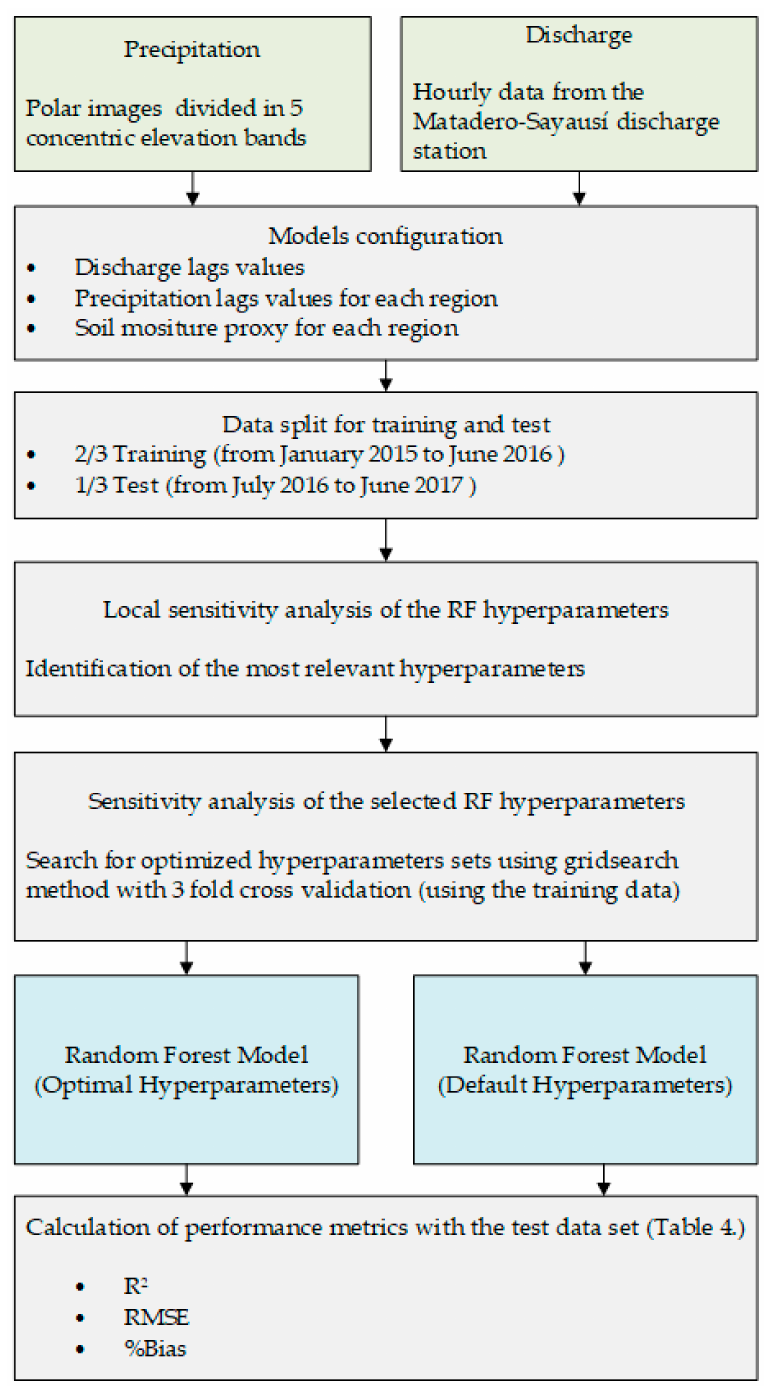
Figure 2. Workflow with the main steps of the methodology of the present